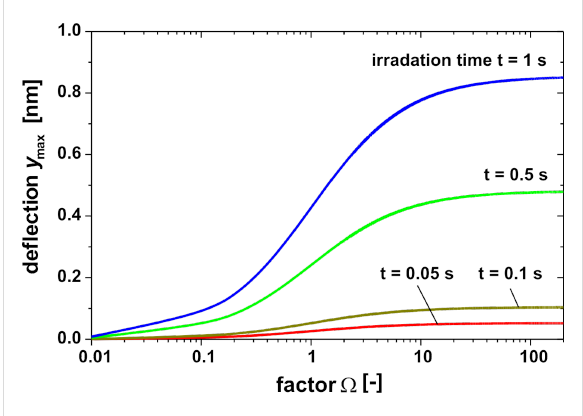
Figure 5: Maximum central deflection y max of a circular membrane as function of factor Ω and irradiation time for a water-filled cavity. IR power density = 10 W/m 2 , diameter and height of the cavity = 0.5